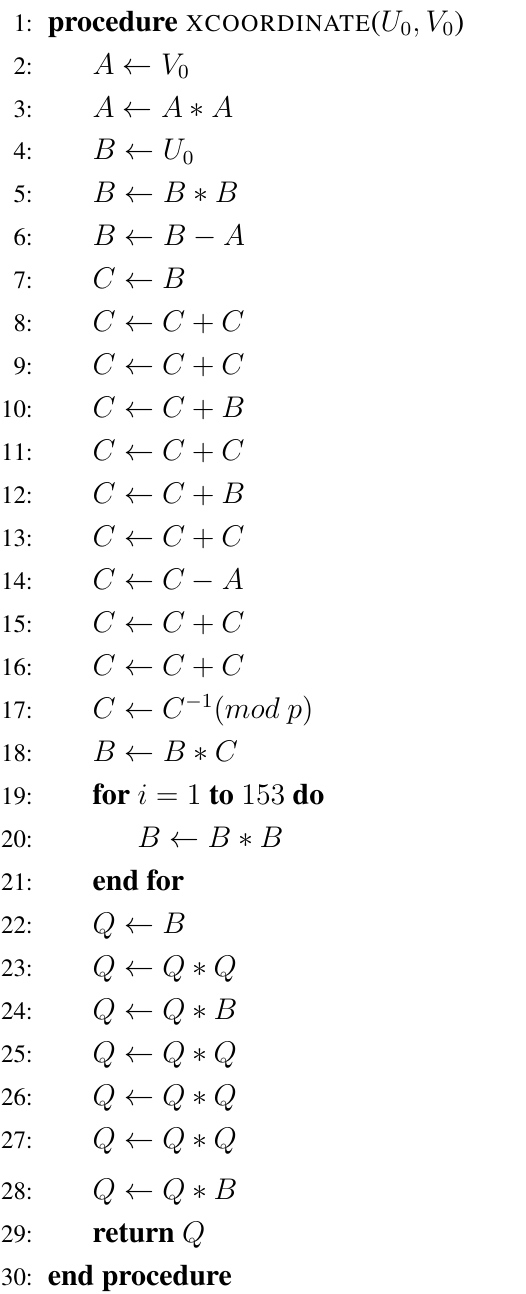
Algorithm 2 Computing the x -coordinate of scalar multiplication when only the original y -coordinate is